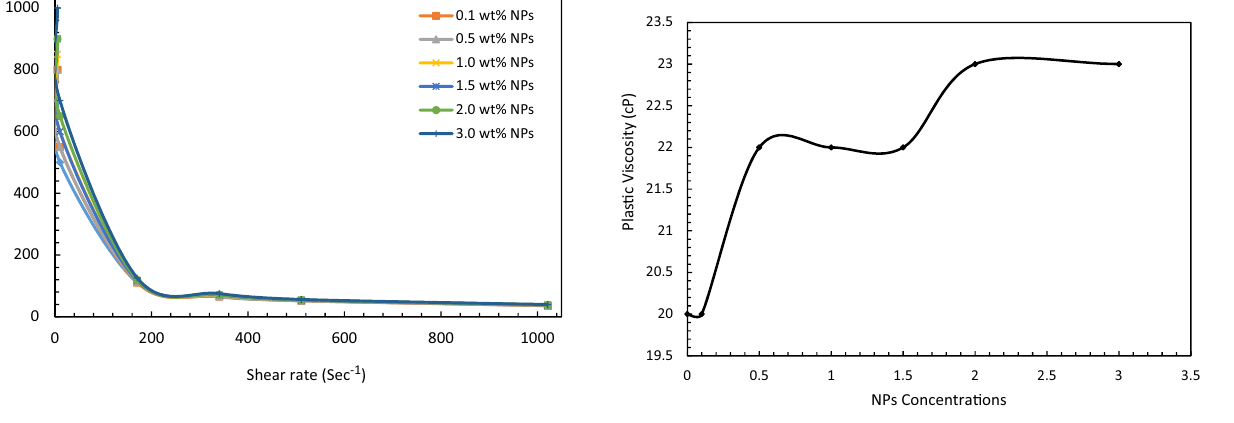
Fig. 6 Effect of concentrations of NPs on plastic